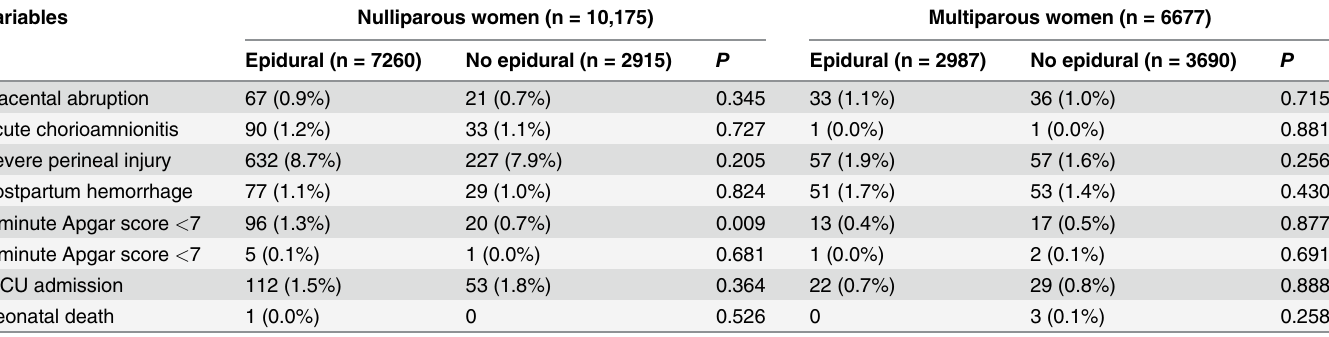
Table 3. Adverse maternal and neonatal outcomes of the nulliparous and multiparous women with or without the use of epidural analgesia during labor.